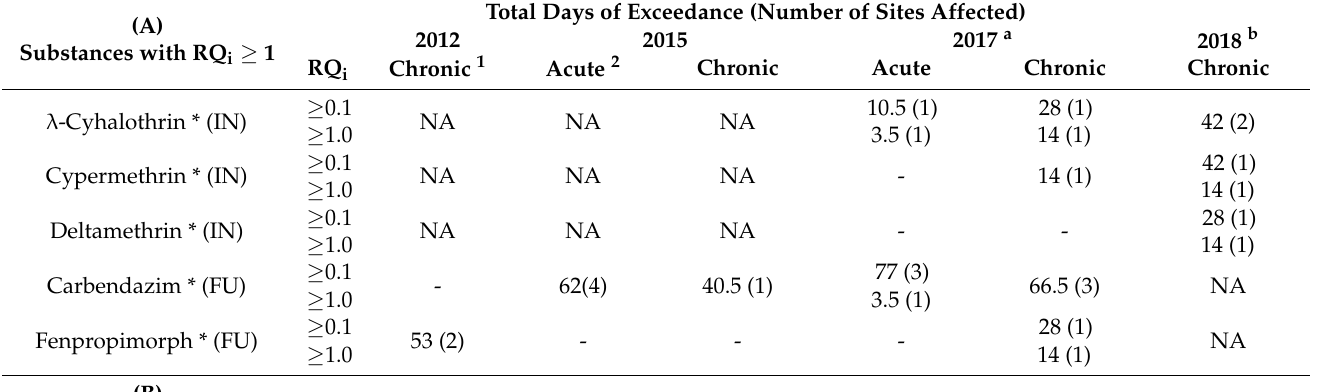
Table 1. Pesticides posing (A) a single substance risk of RQ i ≥ 1 (acute or chronic); (B) a single substance risk of RQ i ≥ 0.1 and <1 (acute or chronic) in at least one water sample based on monitoring data collected in Switzerland (2012–2018). Substances marked with * contributed at least 30% to mixture risk in the respective sample. Total days of exceedance per monitoring year and number of sites are provided in brackets. IN: insecticide; FU: fungicide; HE: herbicide; -: RQ i < 0.1; NA: substance was not